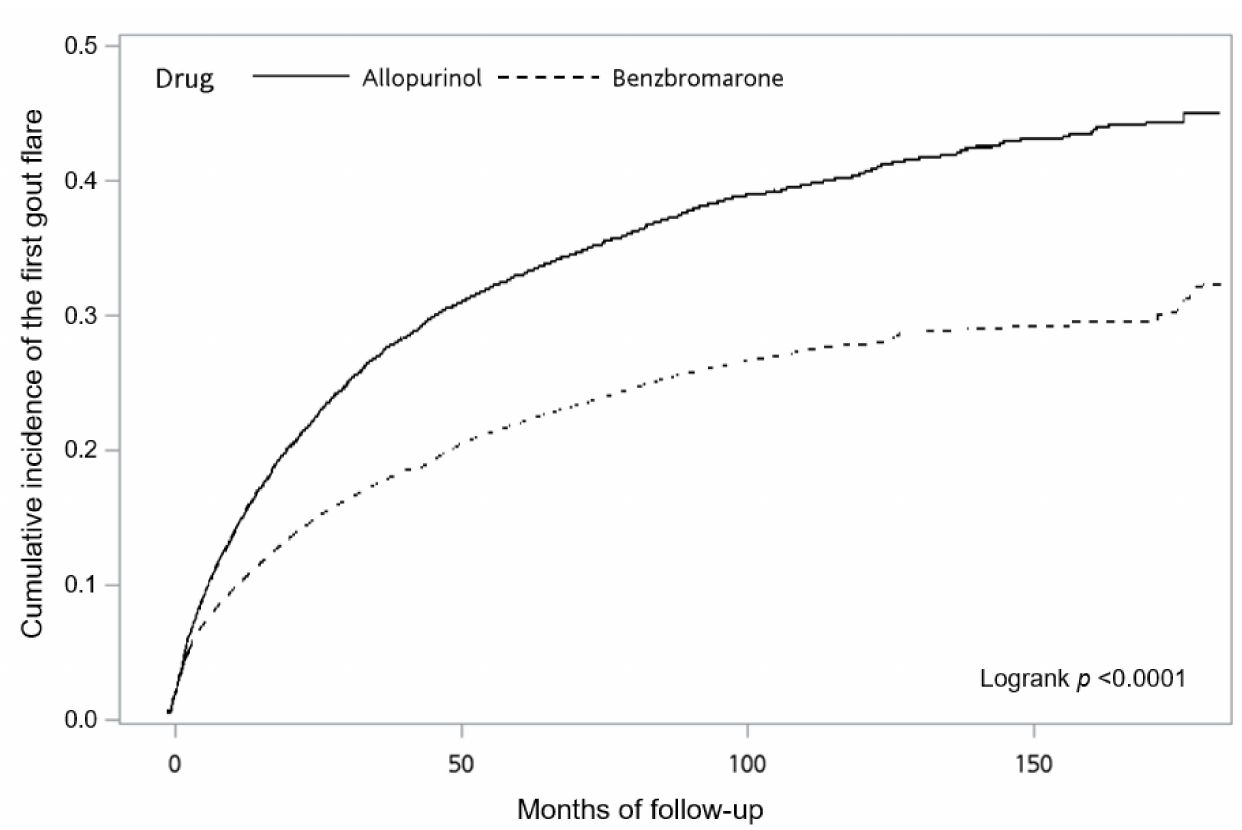
Incidence rate: 1000 person-months; † Incidence rate ratio: benzbromarone use versus allopurinol use (95% CI). The Kaplan–Meier curve showed that the benzbromarone group had a lower cumula- tive incidence of the first gout flare as compared with the allopurinol group at the end of the cohort study ( p < 0.0001, Figure 2).